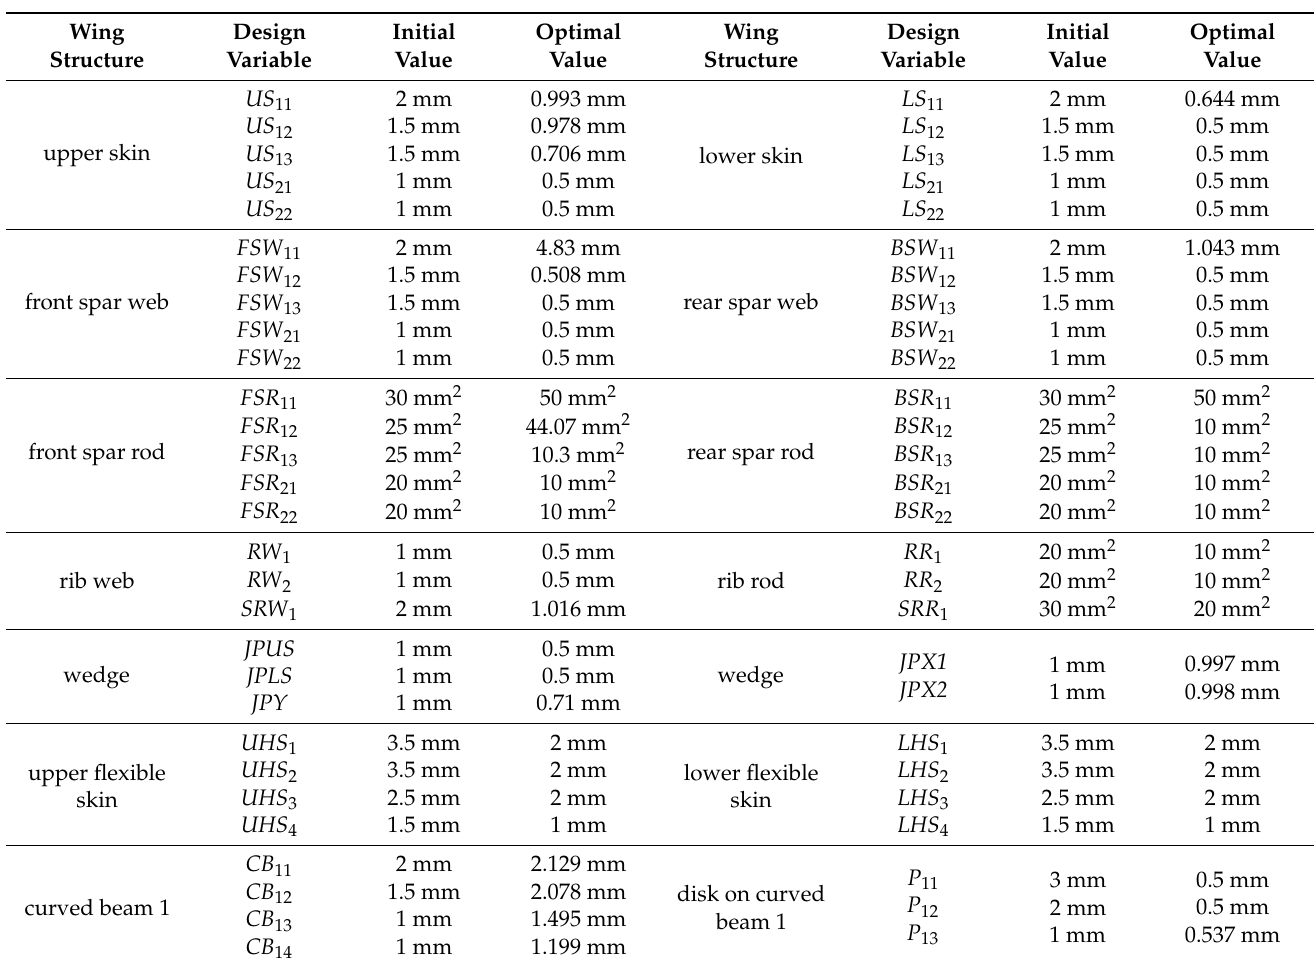
Table 11. Optimization results of wing structure design